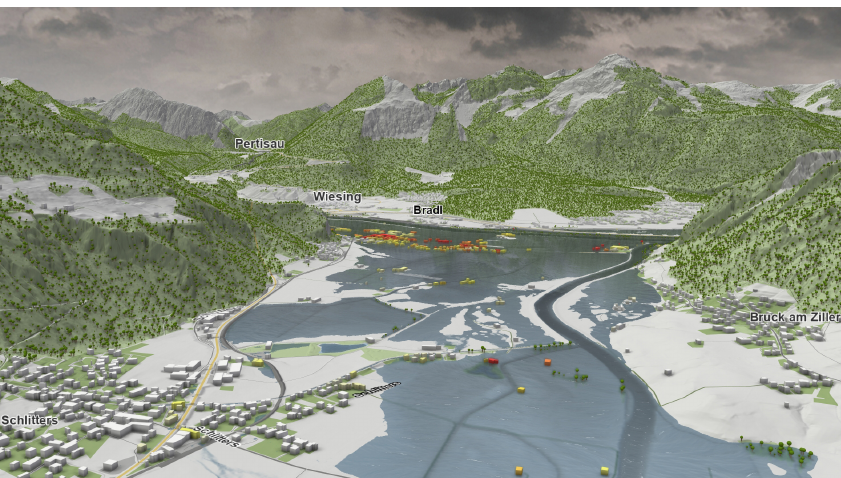
Figure 7. Flood inundation modelling at hyper-resolution in Austria using a 2D hydrodynamic model at 2m resolution nationwide. The flood-hazard zones are associated with a return period of 100 years of the peak runoff. Published by the Ministry of Agriculture, Regions and Tourism as part of the HORA flood risk zoning project on https://www.hora.gv.at (last access: 1 June 2022). (Blöschl et al., 2022).